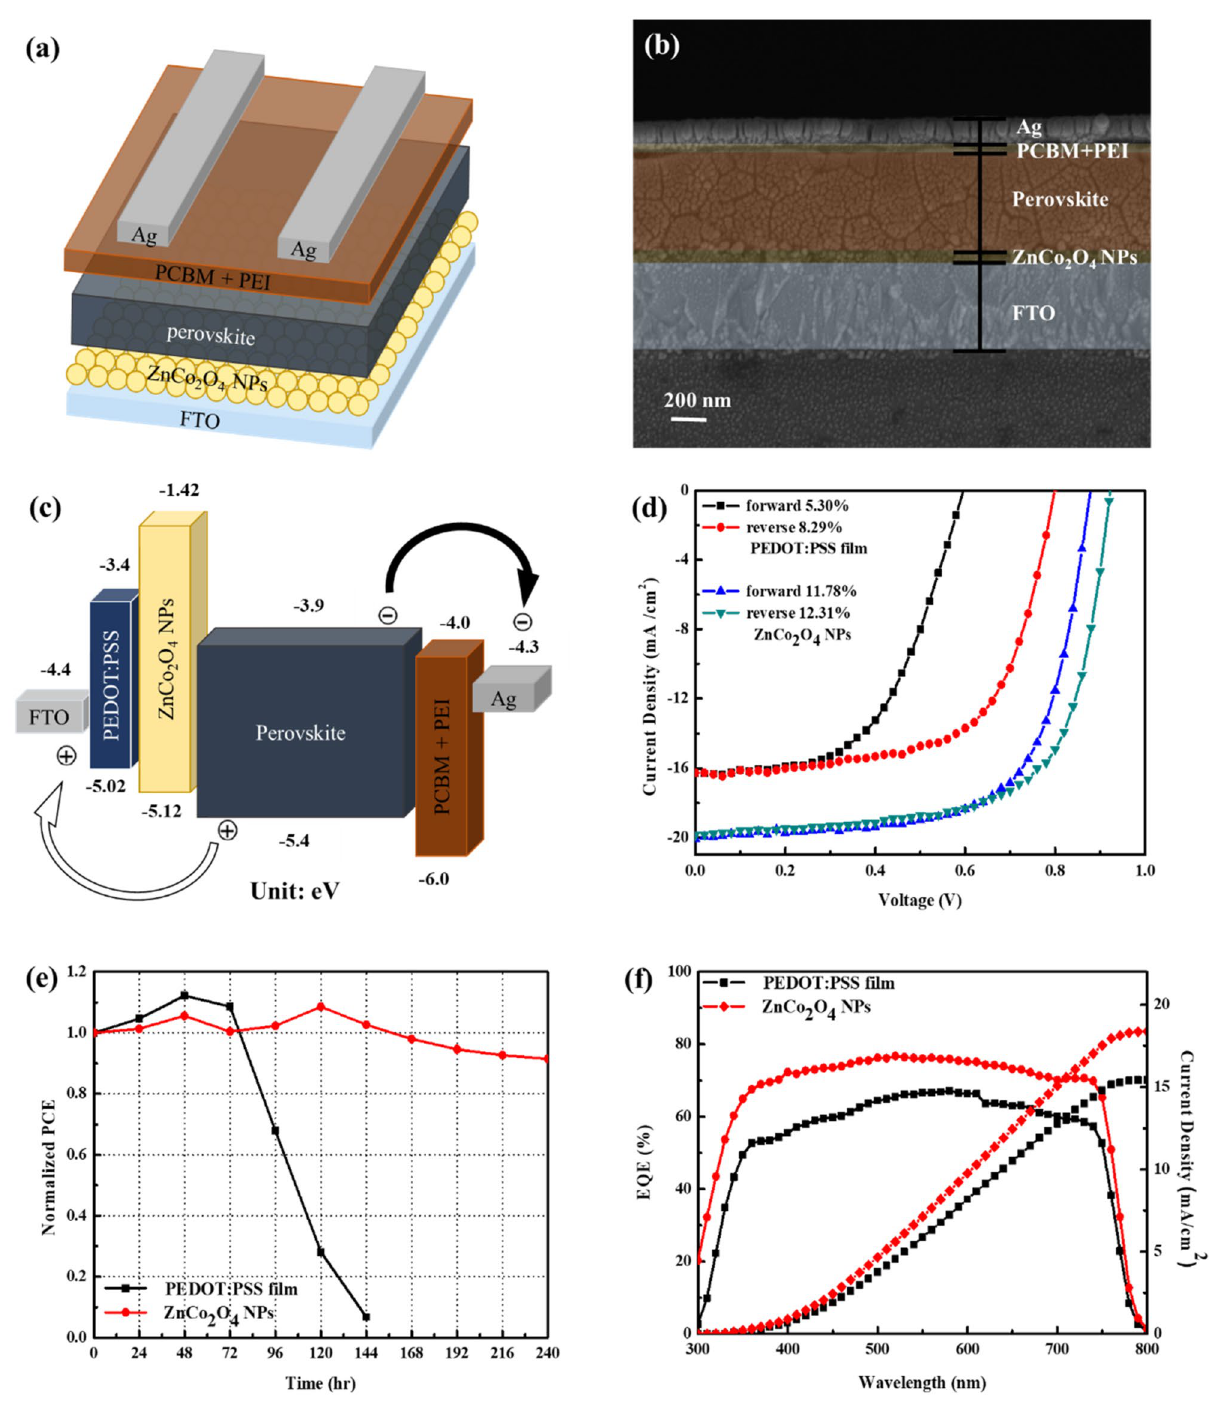
Figure 8. ( a ) Device structure and ( b ) cross-sectional SEM image of the PSC based on the ZnCo 2 O 4 NPs layer; ( c ) energy level diagram of the whole device; ( d ) J-V characteristics, ( e ) normalized PCE evolution, and ( f ) EQE spectra and integrated current density of the PSCs based on PEDOT:PSS film or ZnCo 2 O 4 NPs